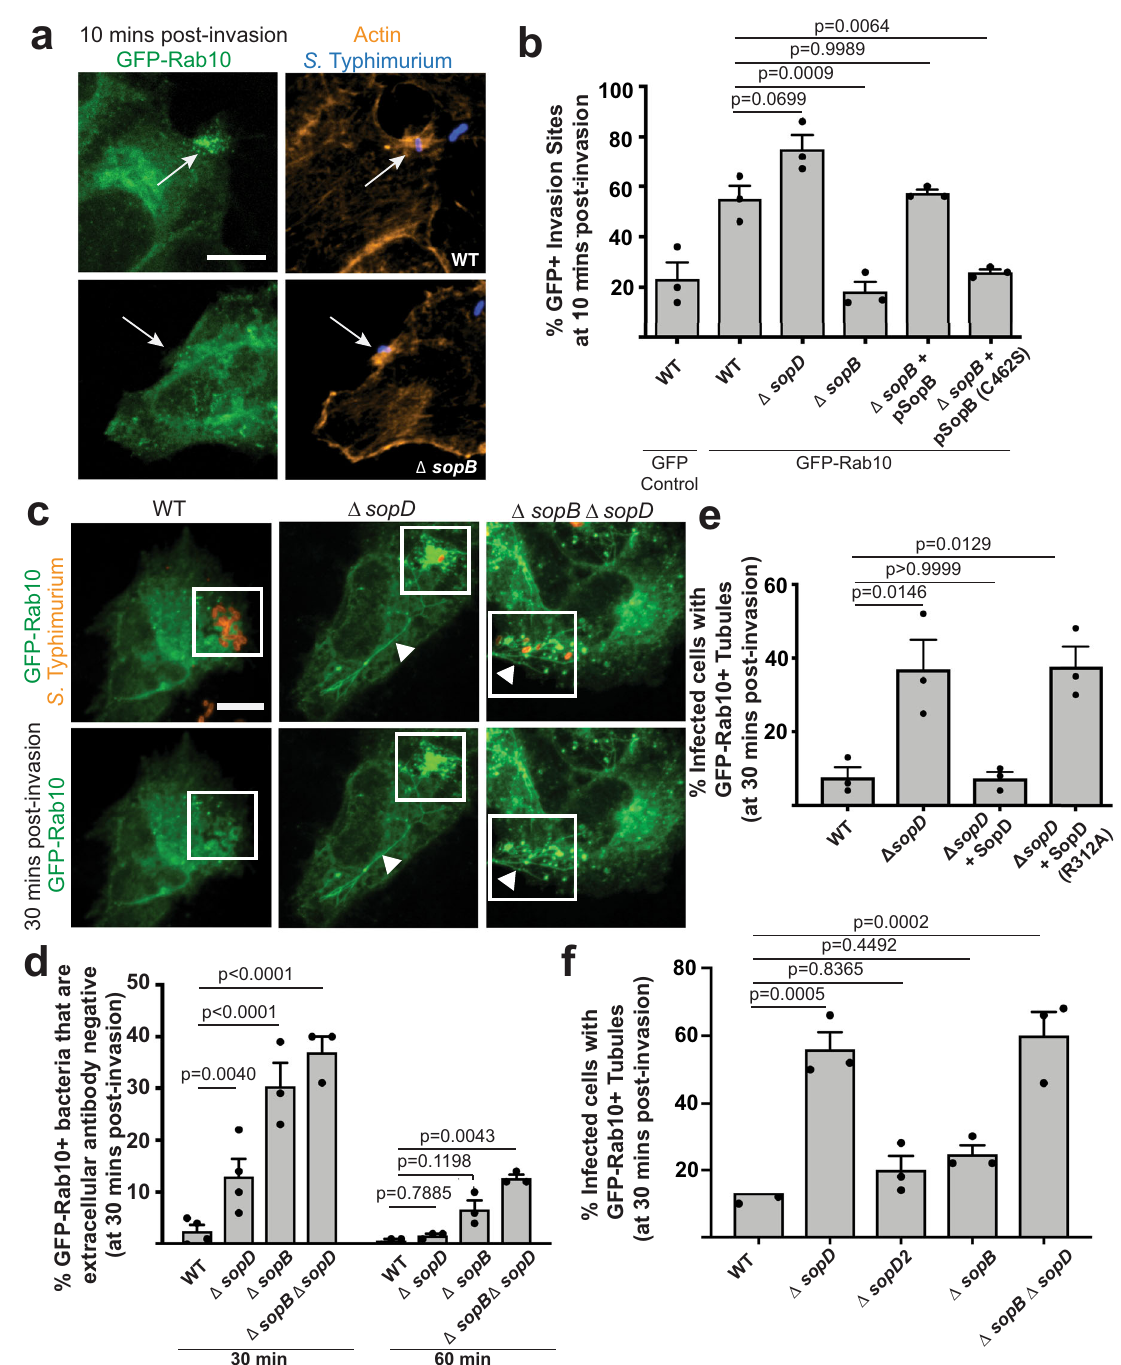
con fi rmed using an antibody targeting endogenous Rab10 (Supplementary Fig. 5b). In contrast, at 30 min p.i., Δ sopD mutant bacteria displayed signi fi cant colocalization with Rab10 (Fig. 2c, d, Supplementary Fig. 5b). We also observed a robust aggregation of GFP-Rab10 + compartments at the invasion site (not directly colocalized with bacteria) of Δ sopD mutant bacteria (Fig. 2c, Supplementary Fig. 8). This aggregation phenotype, at 30 min p.i., was reversed by complementation of the Δ sopD mutant bacteria with WT SopD but not by expression of the SopD(R312A) (Supplementary Fig. 8). Our data suggest that the GAP activity of SopD mediates the removal of Rab10 from S . Typhimurium invasion sites at later stages of bacterial